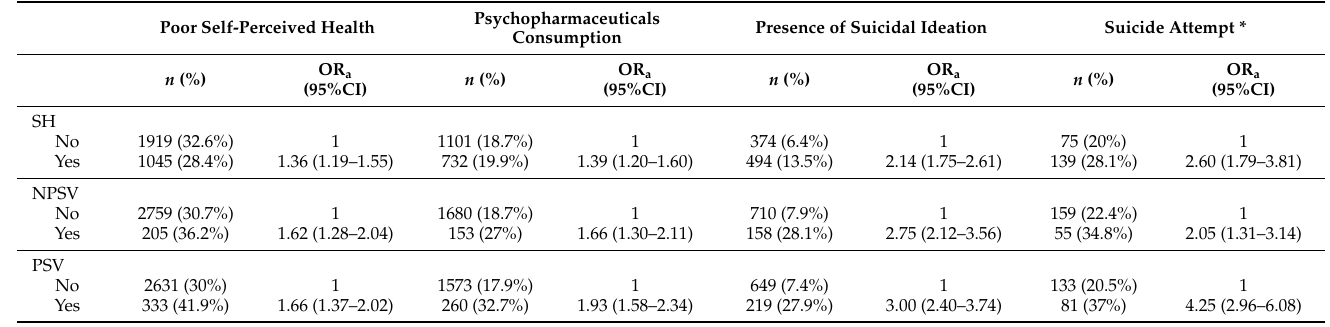
Table 3. Relationship between the three types of sexual violence and indicators of their health impact.